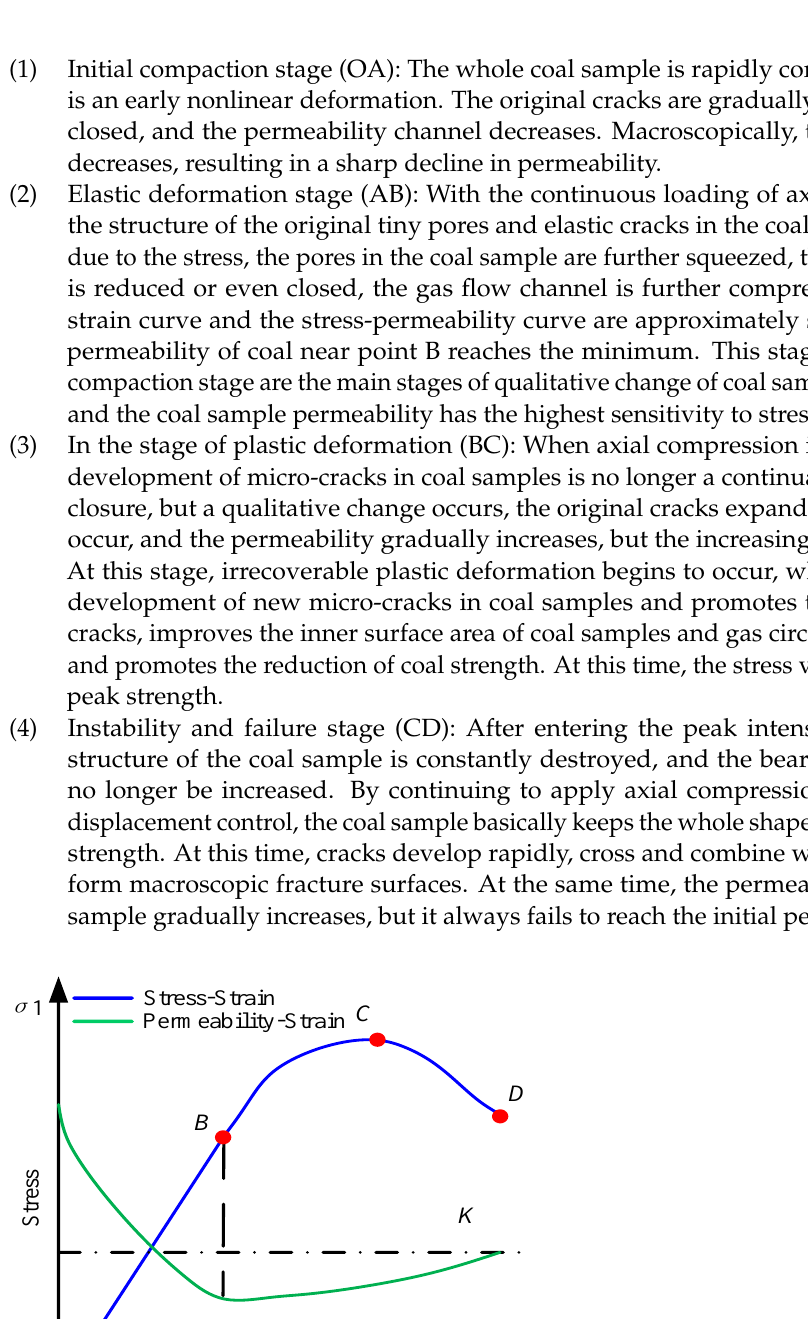
stroyed but can not reach the initial permeability. 3.2. Variation Law of Permeability of Coal Samples under Different Confining Pressures According to the stress path of scheme 2, the relationship between stress difference, permeability, and strain of axially loaded coal samples under constant gas pressure ( p = 1.5 MPa) and different confining pressures ( 2